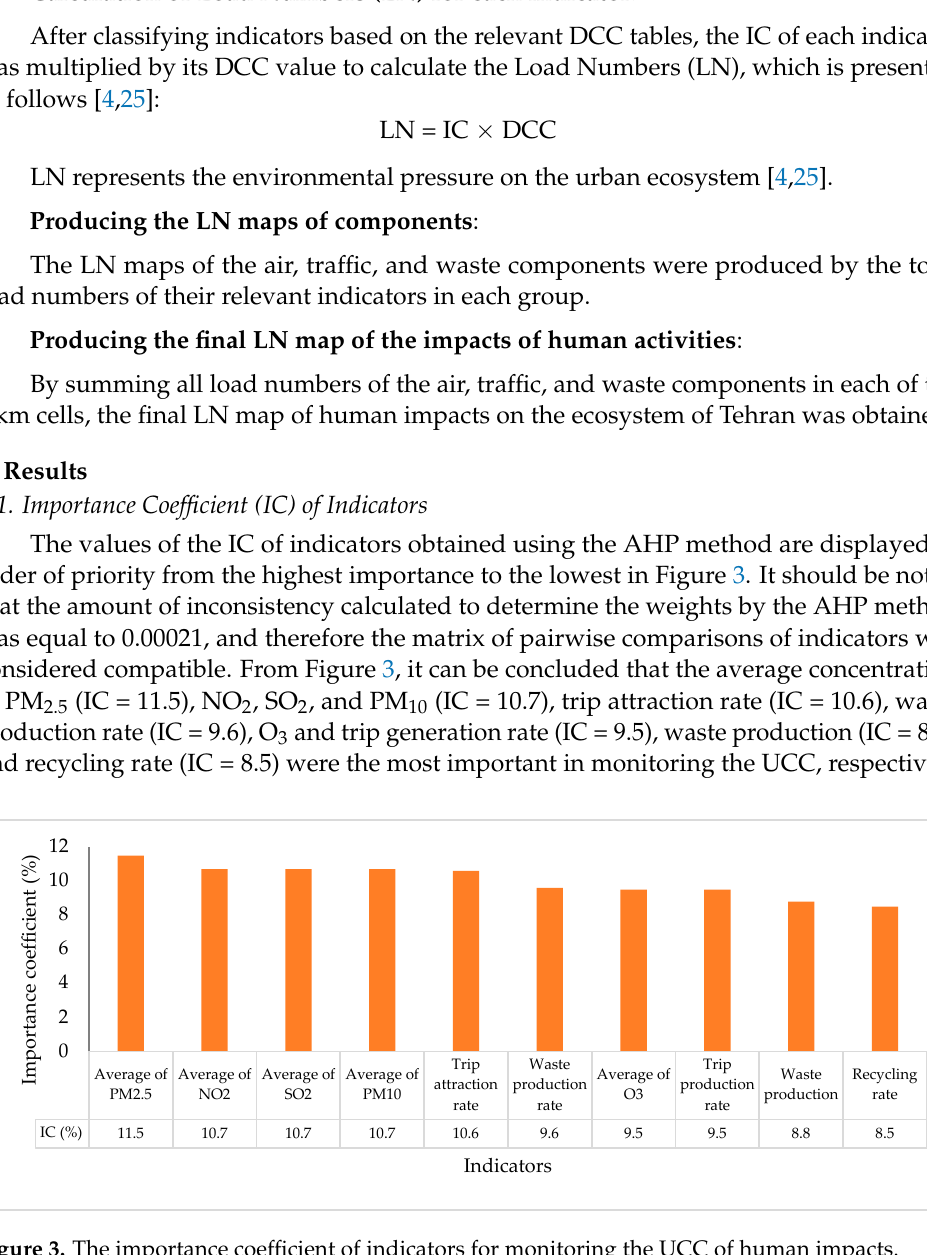
Table 3. DCC classes of indicators.